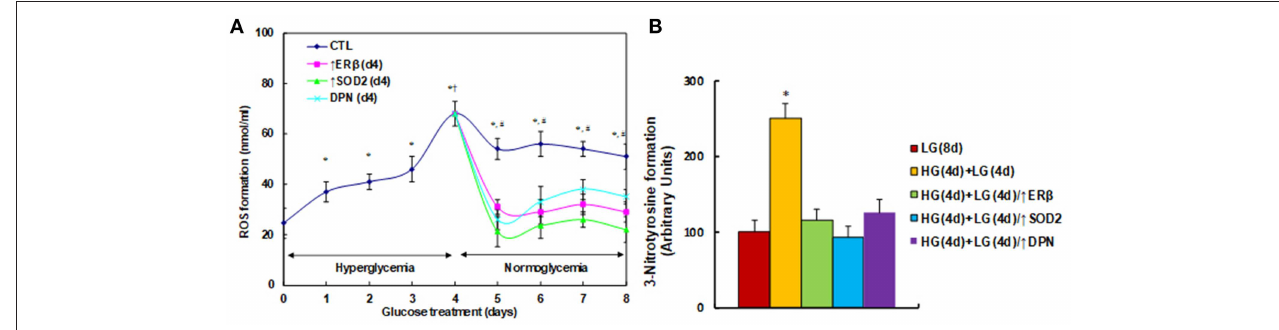
FIGURE 1 | ER β expression diminishes hyperglycemia-induced persistent ROS generation. (A) HUVECs were incubated in hyperglycemia (25mM glucose) for 4 days, and then switched to normoglycemia (5mM glucose) for an additional 4 days. On day 4, cells were infected by an empty vector (CTL), ER β lentivirus (ER β ↑ ), or SOD2 lentivirus (SOD2 ↑ ), or treated by 100 µ M ER β agonist (DPN) for a subsequent 4 days. The cells were harvested each day for analysis of ROS formation, n = 4. * P < 0.05, vs. day 0 group; † P < 0.05, vs. day 3 group; # P < 0.05, vs. day 4 group. (B) The HUVECs cells were treated either in normoglycemia (5mM) for 8 days (LG(8d)), or in hyperglycemia (HG in 25mM glucose) for 4 days followed by normoglycemia (LG in 5mM glucose) for an additional 4 days (HG(4d) + LG(4d)), or the cells were infected at day 4 by either ER β lentivirus (HG(4d) + LG(4d)/ER β ↑ ), or SOD2 lentivirus (HG(4d) + LG(4d)/SOD2 ↑ ), or treated by ER β agonist (HG(4d) + LG(4d)/DPN) for subsequent 4 days, and the cells were harvested for the analysis of 3-nitrotyrosine formation, n = 5. * P < 0.05, vs. LG(8d) group. Data are expressed as mean ±